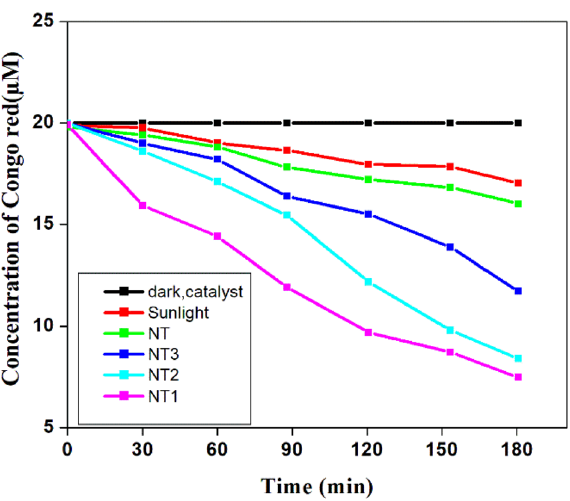
Figure 14. Degradation of Congo red with and without photo catalyst (Initial concentration = 20 µM, Catalyst dosage = 0.5 g l −1 , pH =